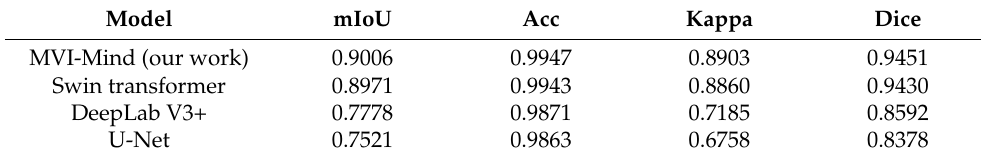
Table 3. Performance comparisons of various deep automatic segmentation models.